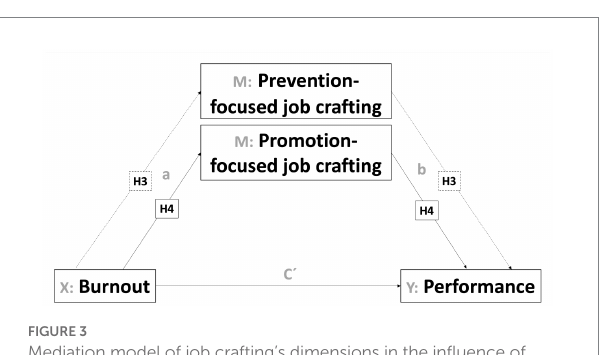
FIGURE 3 Mediation model of job crafting’s dimensions in the influence of burnout on